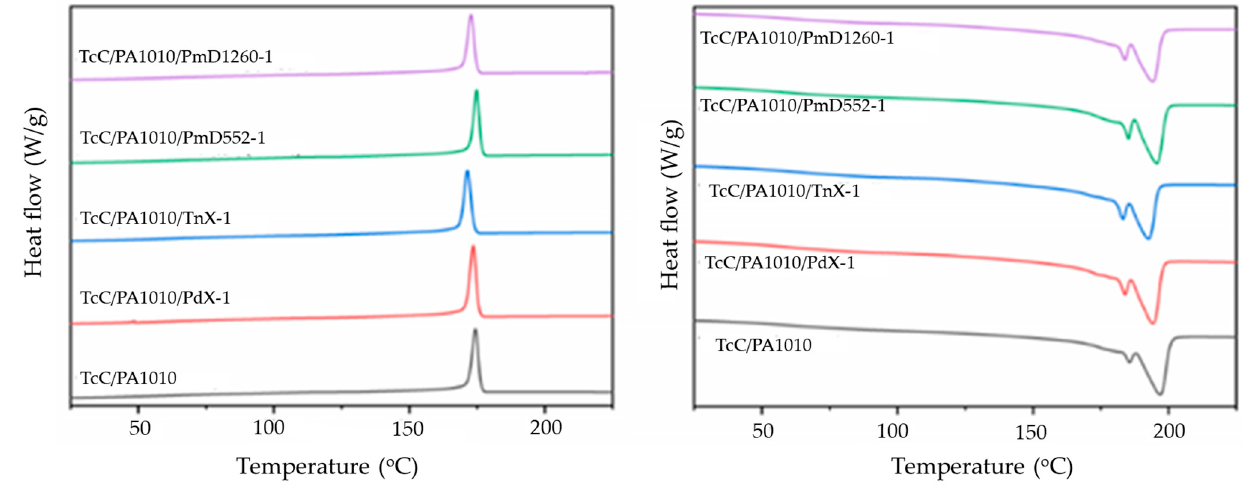
Figure 4. DSC thermograms of TcC/PA1010 blends in the presence and absence of cross-linkers: ( a ) first cooling and ( b ) second heating scans. Table 3. Thermophysical transitions from the DSC and DMA, and thermochemical transitions from the TGA responses of TcC/PA1010 with and without cross-linkers.